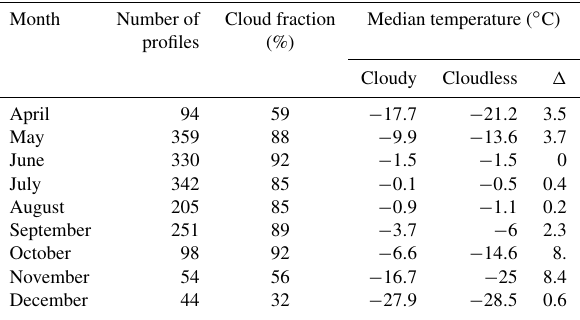
Table 3. Monthly median temperature for cloudy and cloudless pro- files from April to December over the whole IAOOS period. Cloudy profiles contain at least one cloud with a base underneath 2km. Cloudless profiles contain no clouds or (very rarely) contain higher- level clouds. (cid:49) is the difference between cloudy and cloudless pro- file median